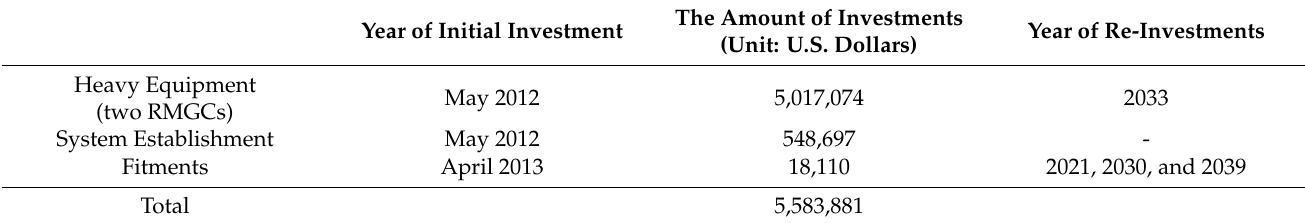
Table 6. Average unit unloading price per year (unit: U.S. dollars).